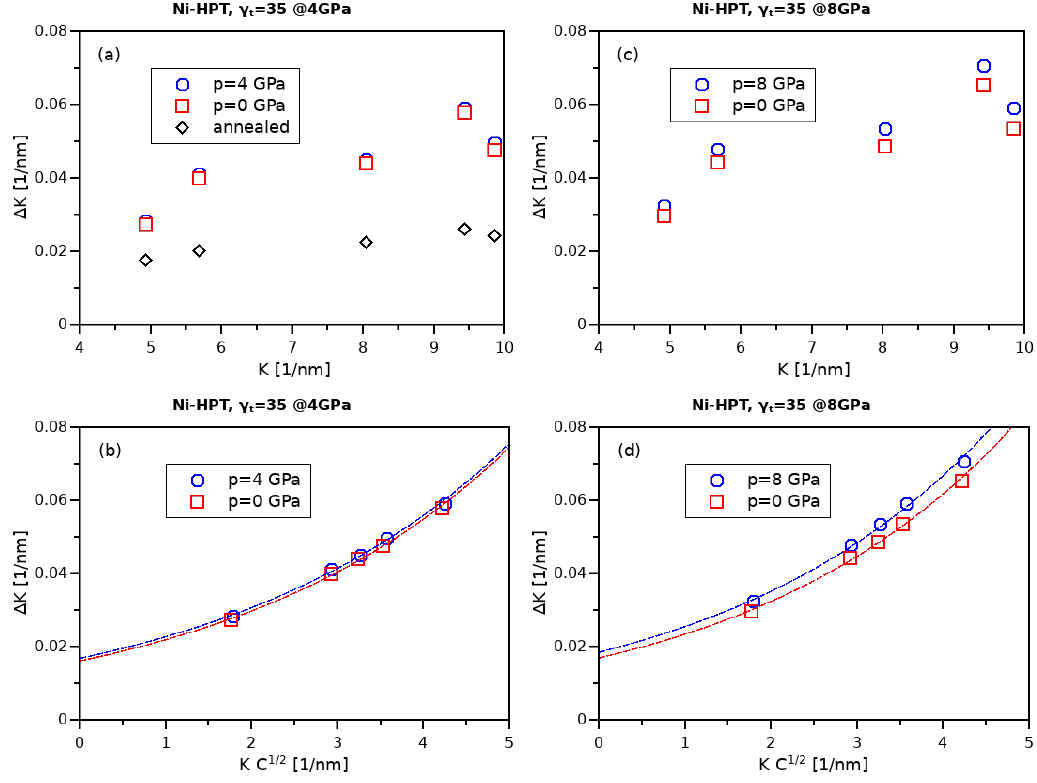
Figure 5. Williamson–Hall plot as well as modified Williamson–Hall plot for Nickel deformed at 4 ( a , b ) and 8 GPa ( c , d ), respectively. “ p = 0 GPa” denotes the sample state after the pressure release